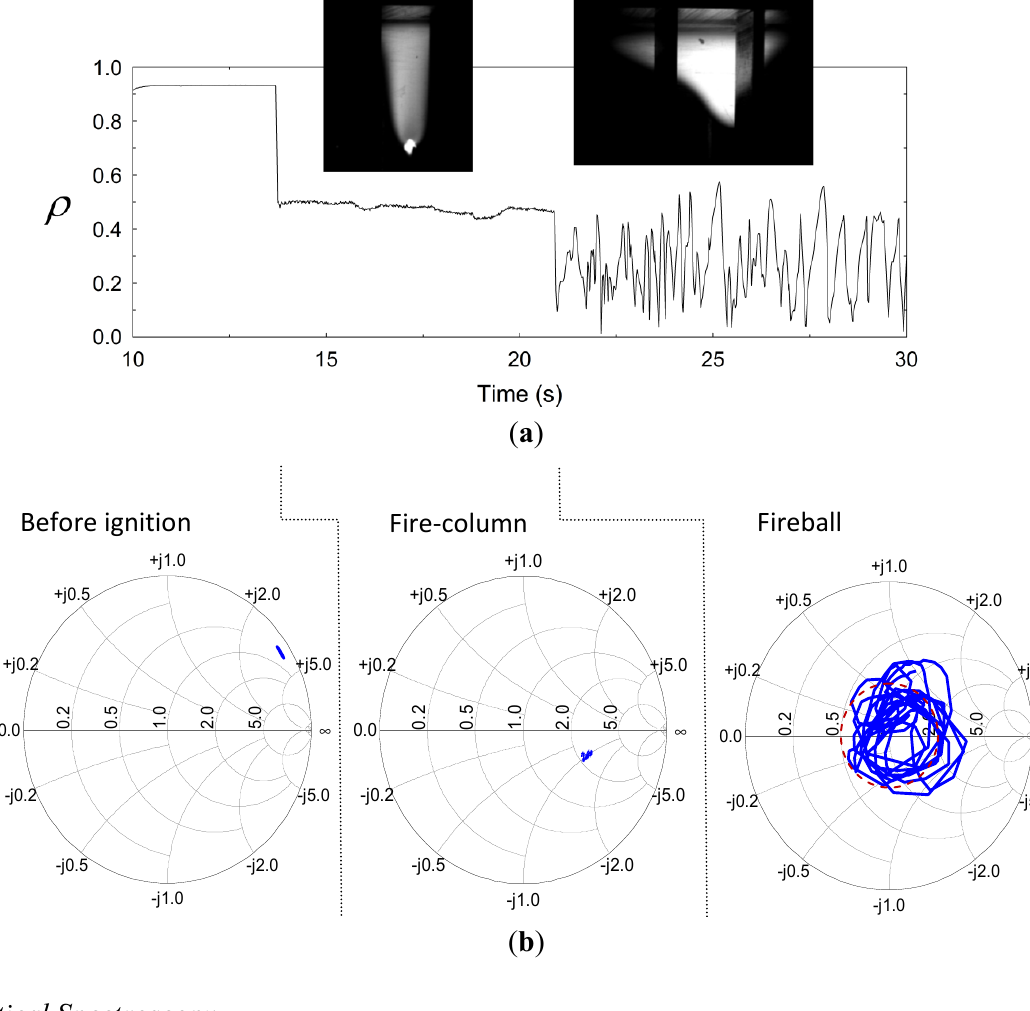
Figure 3. The microwave reflections from the cavity before and after ignition: ( a ) The autonomous reduction in the reflected power upon ignition of the fire-column, and its fluctuation in the fireball stage, being attracted by a minimal reflection level and ( b ) Smith-chart presentations of the cavity’s input impedance, before ignition, during the fire-column stage, and in the consequent fireball stage (the latter shows the tendency of the fireball to reach a self impedance